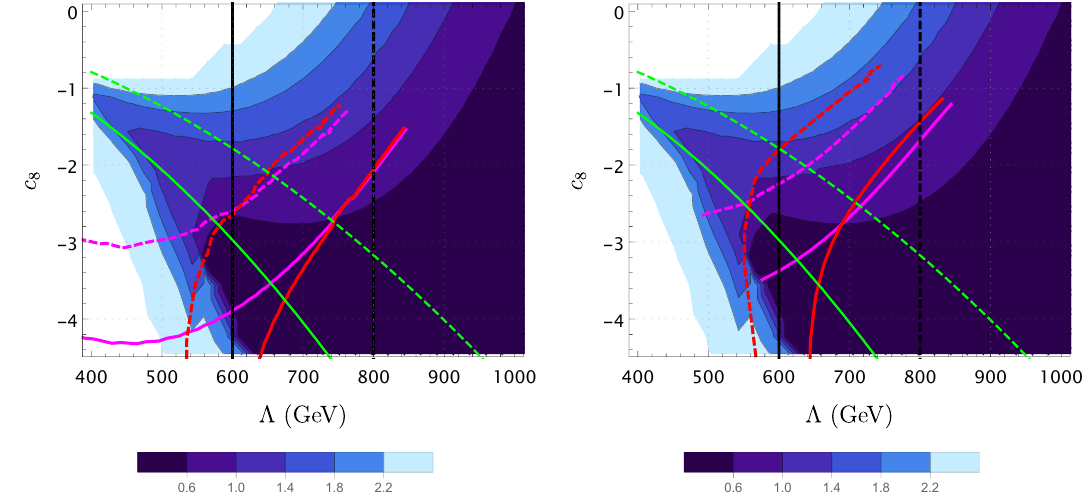
(b) Strength of the first order phase transition R N as function of the EFT parameters Λ and mass c 8 . The red lines for constant R N in the singlet model are mapped to the corresponding SMEFT parameters for κ = 4 (left plot) and κ = 2 (right plot). Figure 2. Parameter space for a SFO-EWPT in the singlet extension of the standard model (top row) and SMEFT (bottom row). The solid (dashed) red lines correspond to R = v N = 1 (1 . 4) N T N in the singlet model; the magenta lines show the same mapping of the equi- R but without the N inclusion of the box-operators in the EFT, i.e., for c = 0 . Further, the solid (dashed) green kin lines correspond to a = 0 . 5 (0 . 3) and theq solid (dashed) black lines to Λ = 600 (800) GeV in 2 /a 8 v 6 SMEFT. These lines are mapped between Higgs-singlet model and SMEFT parameters and shown in both plots for κ = 4 (right side) and κ = 2 left side; in both cases ( g ) = (0 , 1) s , λ s